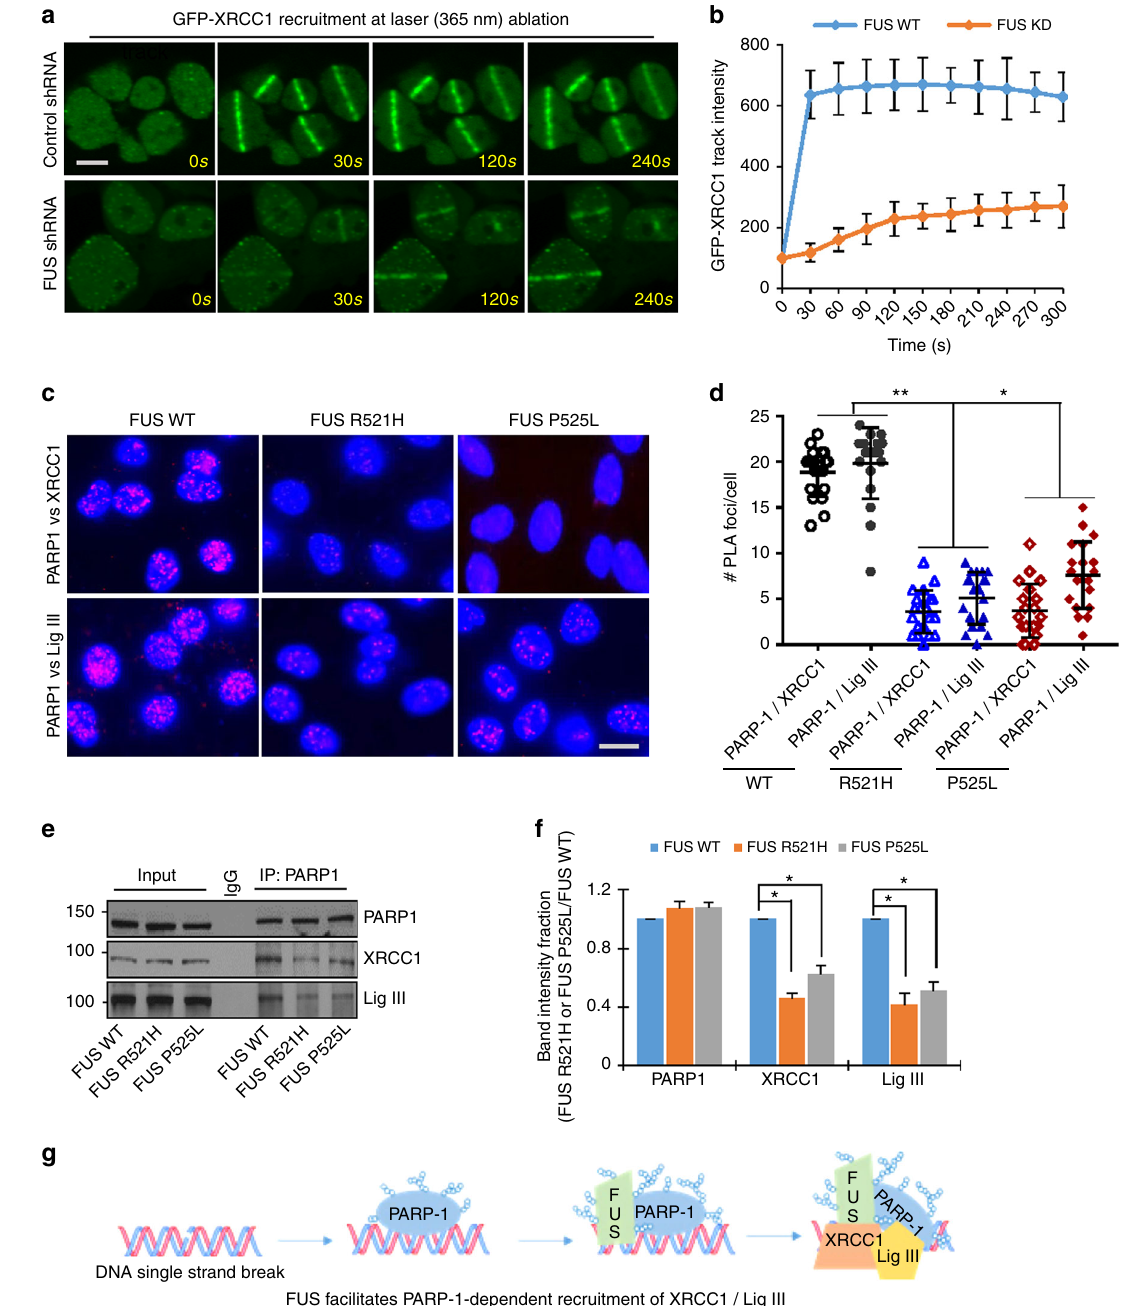
Fig. 8 FUS facilitates PARP-1-dependent recruitment of XRCC1/LigIII. a , b Laser ablation microscopy for recruitment of GFP-XRCC1 after FUS knockdown. GFP-XRCC1 and FUS shRNA were co-transfected into HEK293 cells followed by laser treatment and microscopy 48 h after the transfection, as in Fig. 7a. Scale bar = 5 µ m. Histogram shows the intensity of GFP-XRCC1 at laser track (see movie clip in Supplementary Movie 4 and 5 for live imaging). The error bars are standard deviation. c , d PLA of PARP1 vs XRCC1 and PARP-1 vs LigIII in WT or FUS mutant patient-derived motor neurons after GO treatment. Nuclei stained with DAPI. The average number of PLA foci from 25 cells were quanti fi ed. The error bars are standard deviation (* p < 0.05; ** p < 0.01, two- tailed unpaired Student ’ s t -test). Scale bar = 5 µ m. e , f XRCC1 co-IP (endogenous) from WT or FUS mutant patient-derived fi broblast lines and IB probed for PARP-1 and XRCC1. Histogram shows quantitation of IB band intensity. The error bars are standard deviation of experiments performed in triplicate (* p < 0.05, two-tailed unpaired Student ’ s t -test). g A model showing that PARP-1-dependent recruitment of XRCC1/LigIII at DNA SSBs is facilitated by